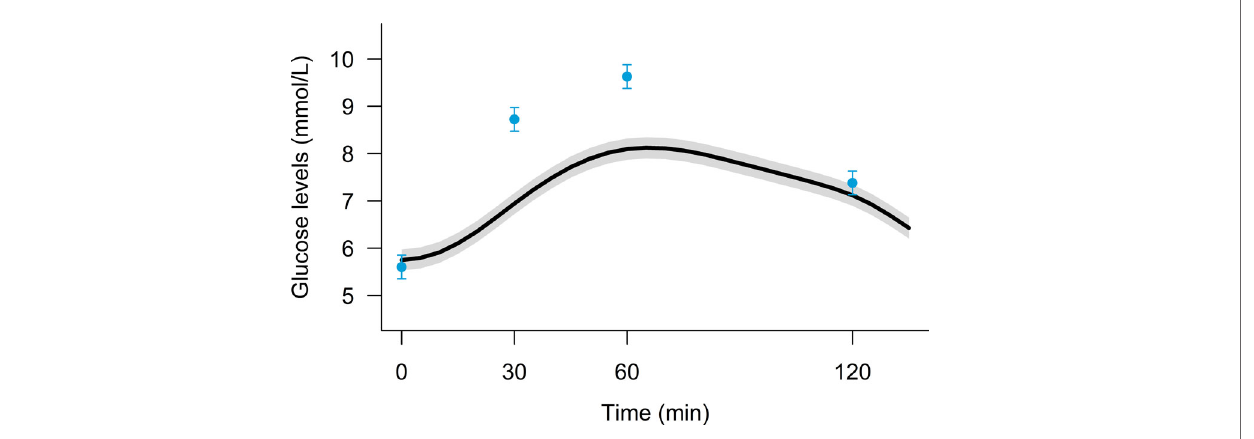
FIGURE 3 | Mean (95%-CI) plasma glucose levels measured during the OGTT (blue points) and simultaneously by the continuous glucose monitoring device (black curve) in 120 persons with prediabetes examined three times over